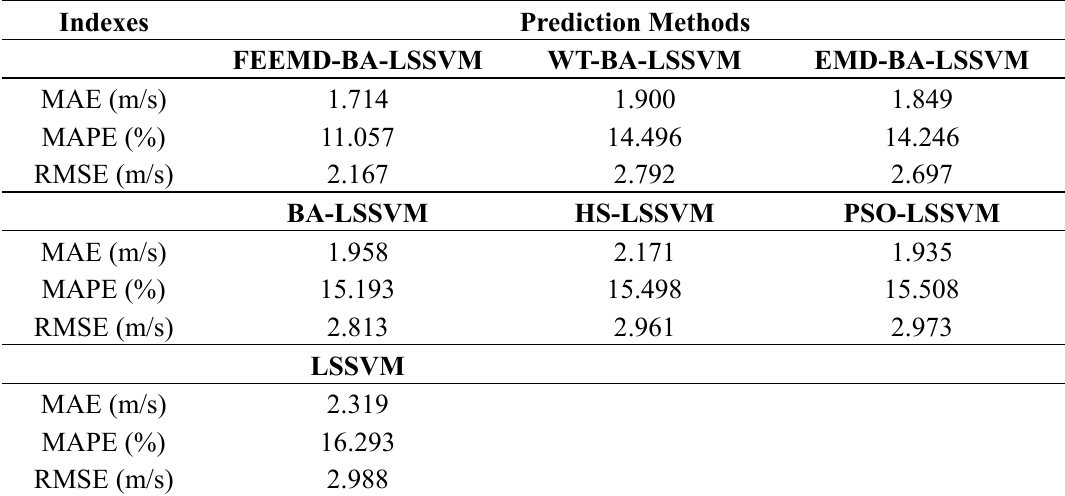
Table 9. Analysis of the predictions with temperature as argument.